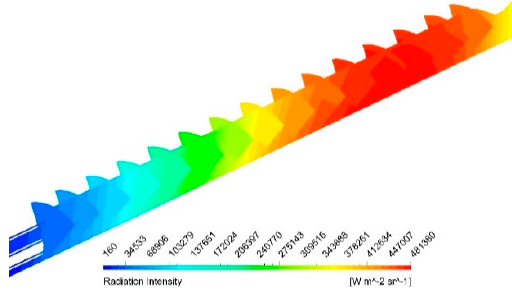
Figure 14. The Gray model radiation intensity (50% axial scaling).